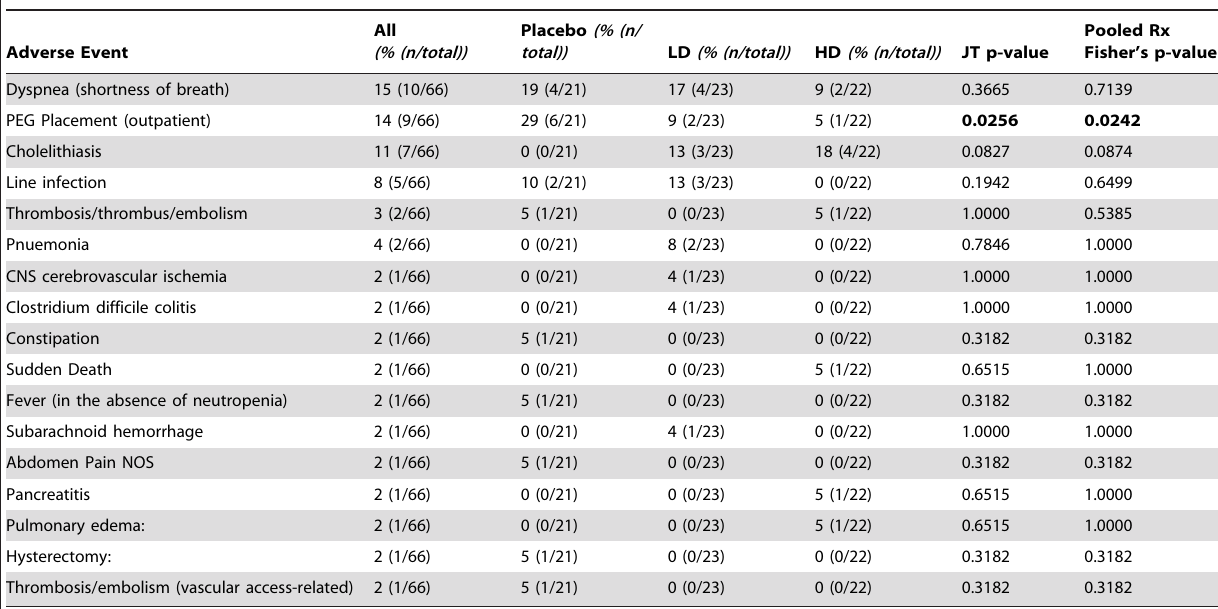
Table 3. Serious Adverse